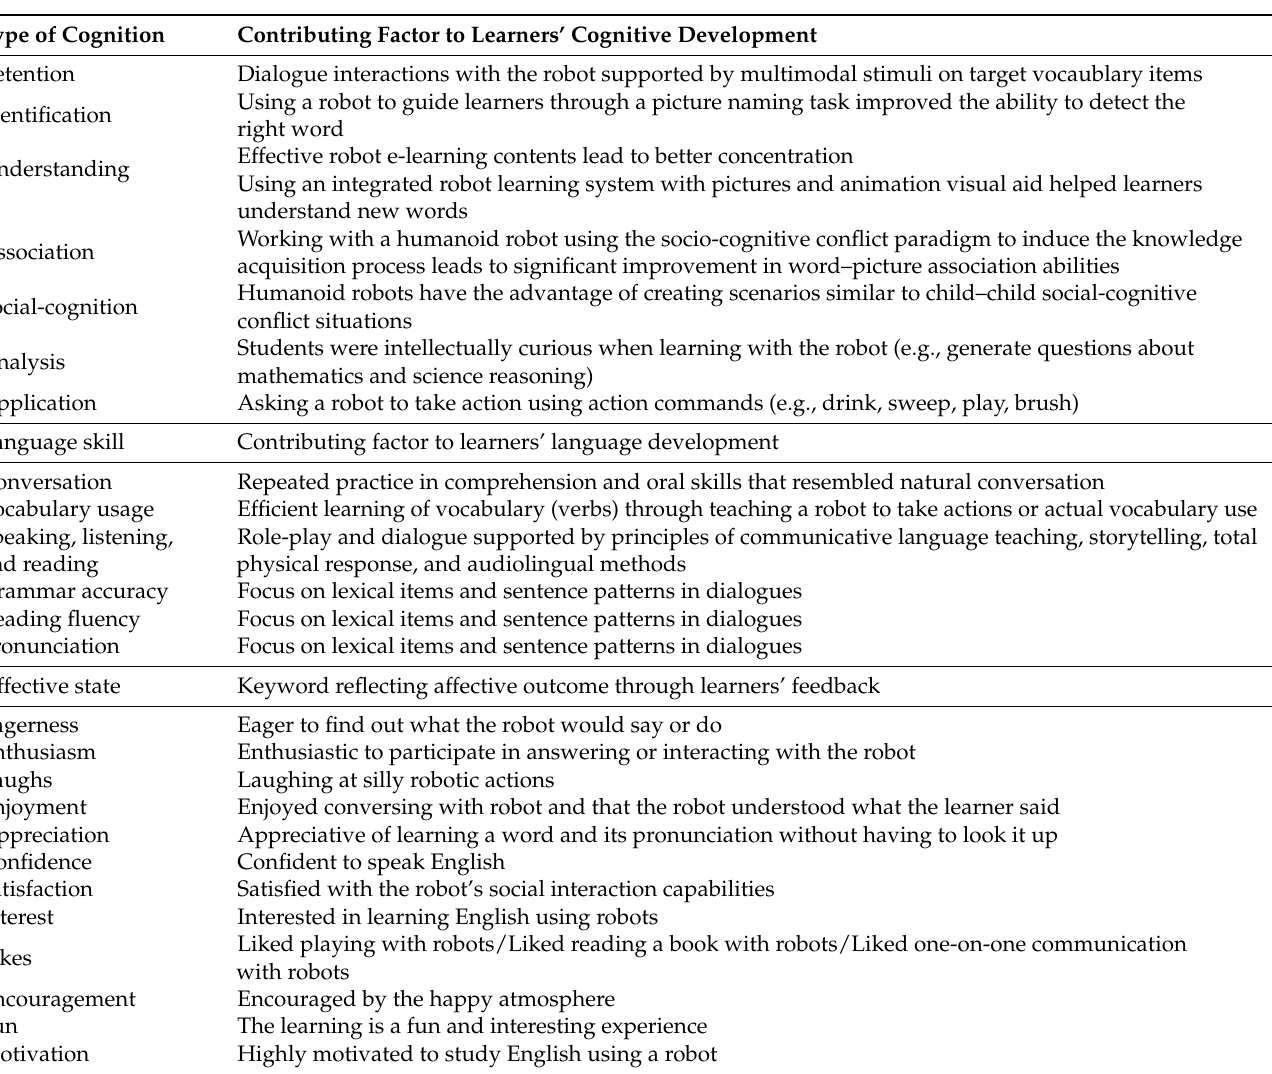
Table 3. Positive Cognitive, Skill, and Affective Learning